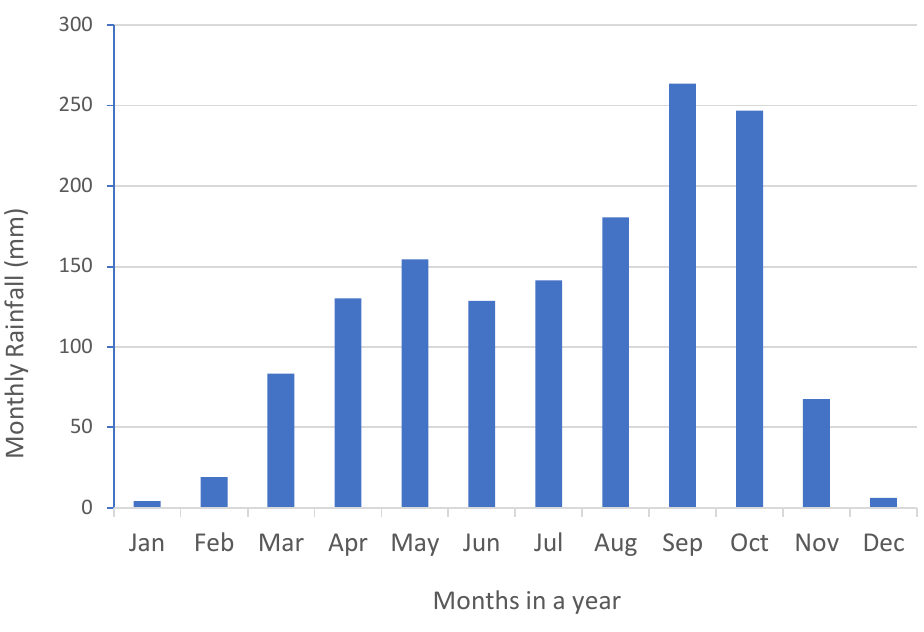
Figure 2. Average monthly rainfall distribution for the years 1951–2021. Data from Ref. [18] were actualized.